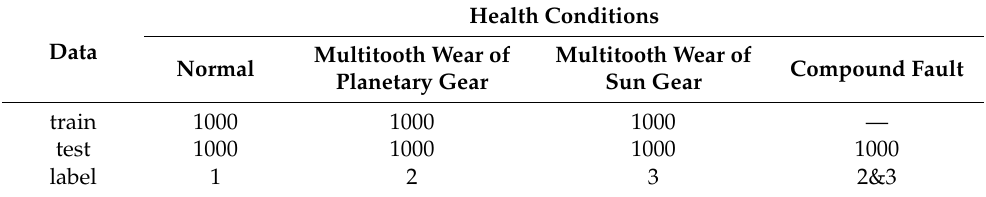
Table 1. RV reducer data description. Health Conditions Data Multitooth Wear of Normal Planetary